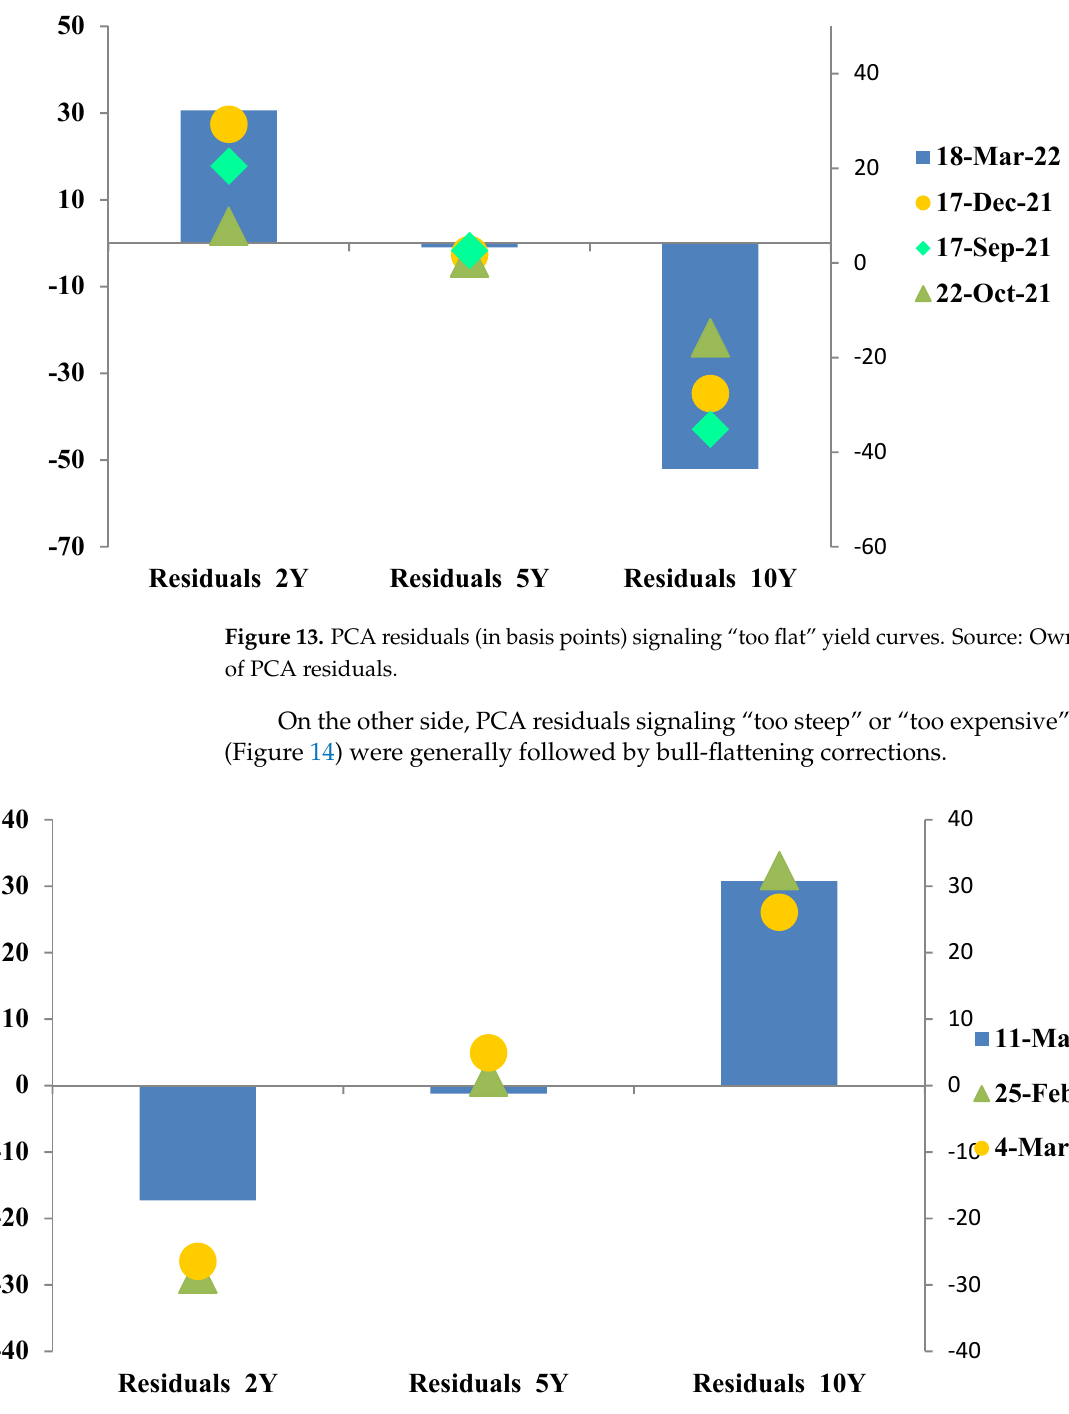
Figure 14. PCA residuals (in basis points) signaling “too steep” yield curves. Source: Own computa- tion of PCA residuals.